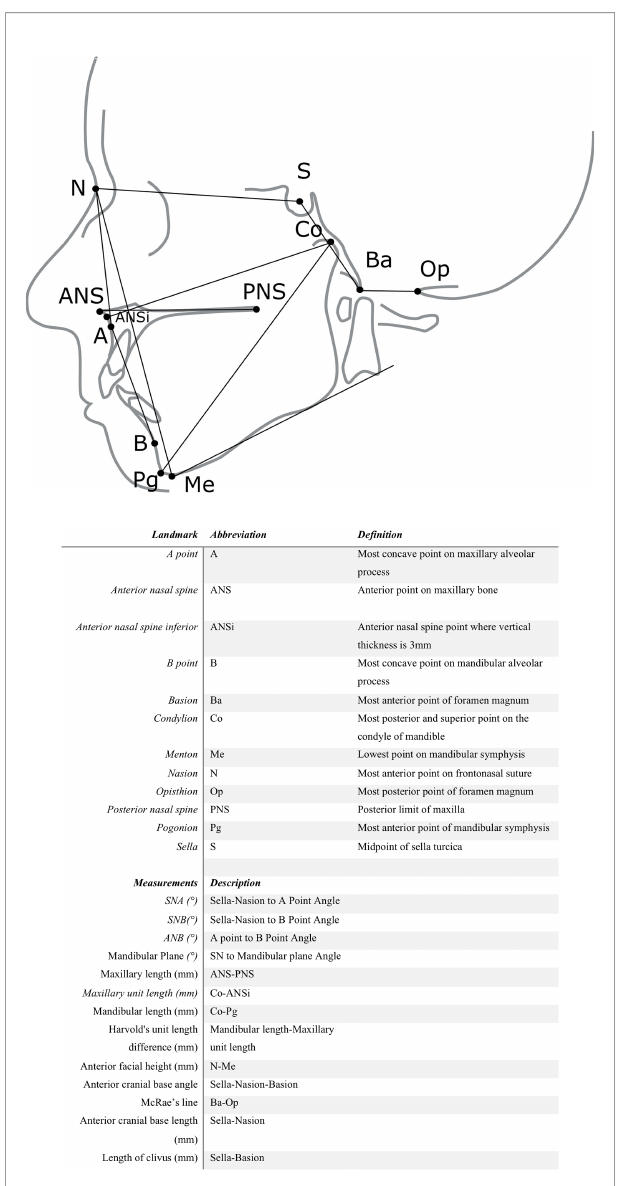
FIGURE 1 | Anatomic landmarks, cephalometric reference planes, linear, and angular